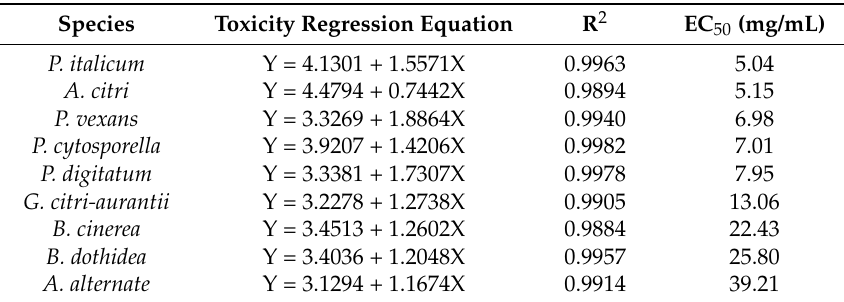
Table 5. Toxicities of the FH extracts against